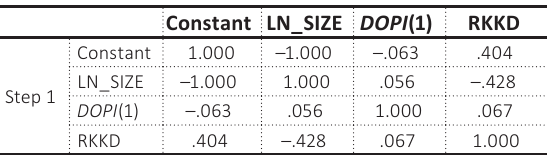
Table 5. Independent correlation matrix